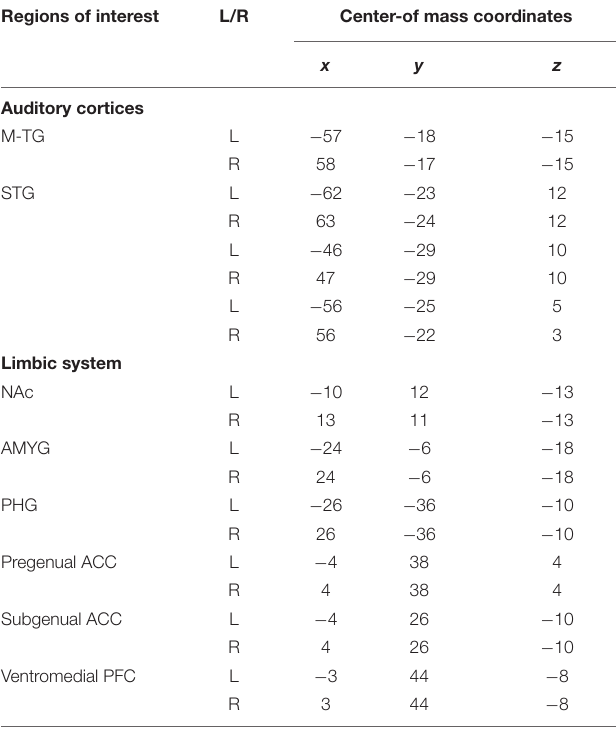
TABLE 1 | Seed regions of interest, center coordinates in MNI